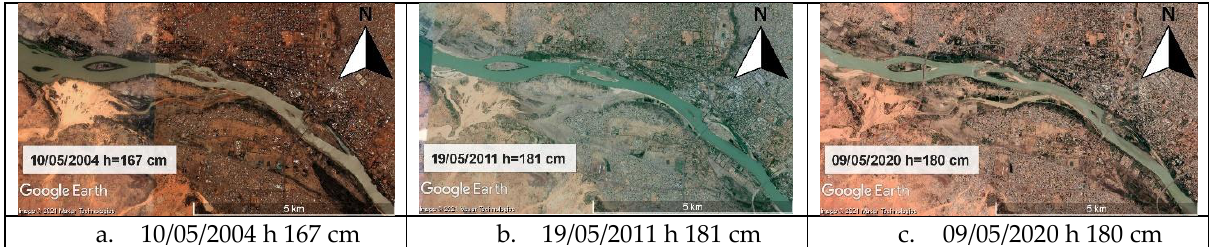
Figure 17. Evolution of the Niger river main channel in Niamey between 2004 and 2020. The alluvial fans of small koris upstream (Kourtéré for instance, on the left in figures 17 a, b and c) showed a dramatic increase since the 1980s [24,65] but have not changed so much since 2002. Conversely, the urban drainage channel of ‘ Palais de Congrès ’ shows a clear strong increase of the fan between 2002 and 2020 (Figure 18 a, b and c between the bar and the bridge) which can partially obstruct the discharge at low water level but prob- ably has small relevance in high water levels. a.